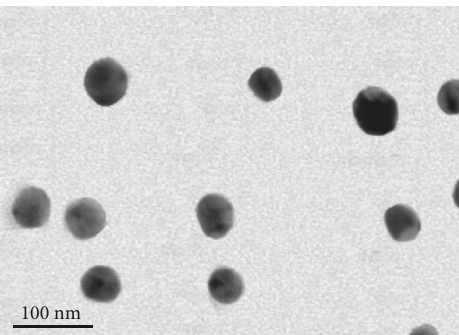
Figure 2: Transmission electron microscope micrographs of Cur- PLGA-Nps, (scale bar represents 100